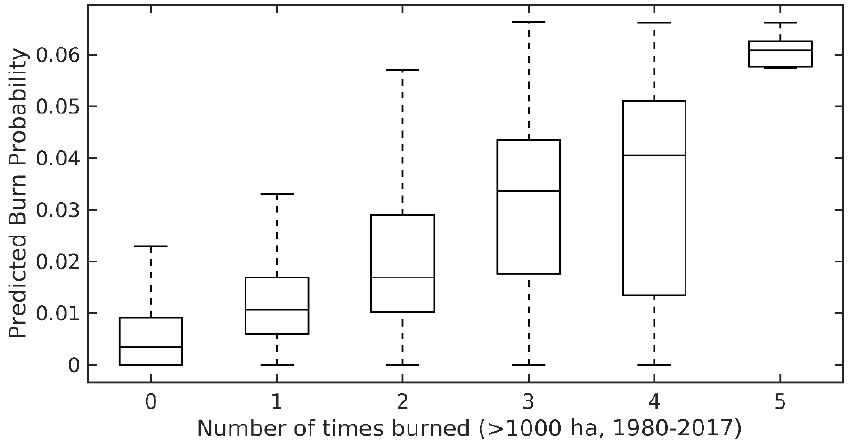
Figure 5. Comparison between the spatial distribution of observed frequency of very large wildfires between 1980 and 2017 and predicted burn probability.